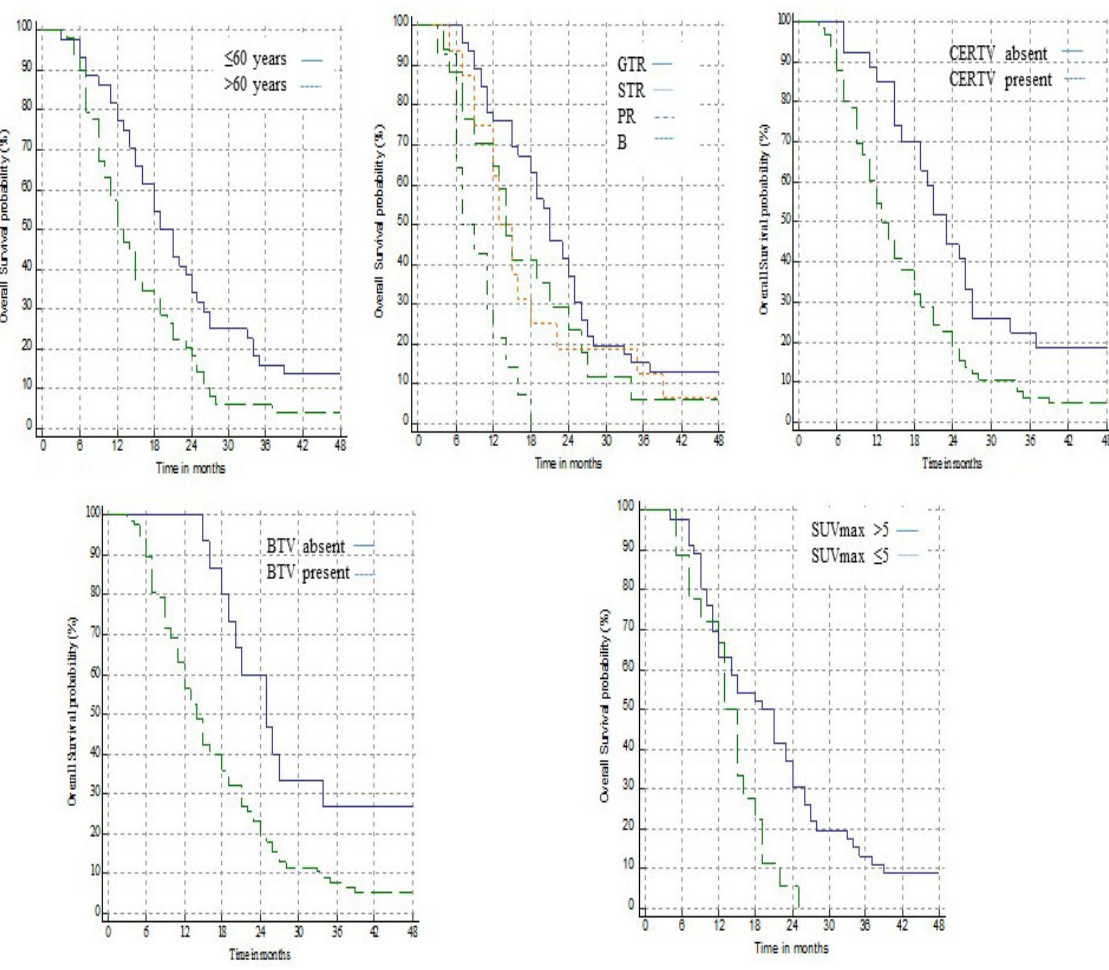
Figure 4. Prognostic factors impacting overall survival. GTR—gross total resection; STR—subtotal resection; PR—partial resection; CERTV—contrast enhances residual tumor volume; BTV—biological tumor volume.